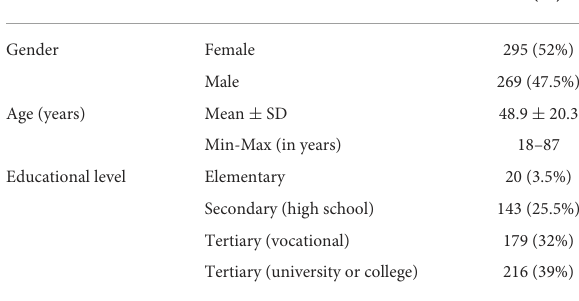
TABLE 1 Demographic characteristics of the study participants #